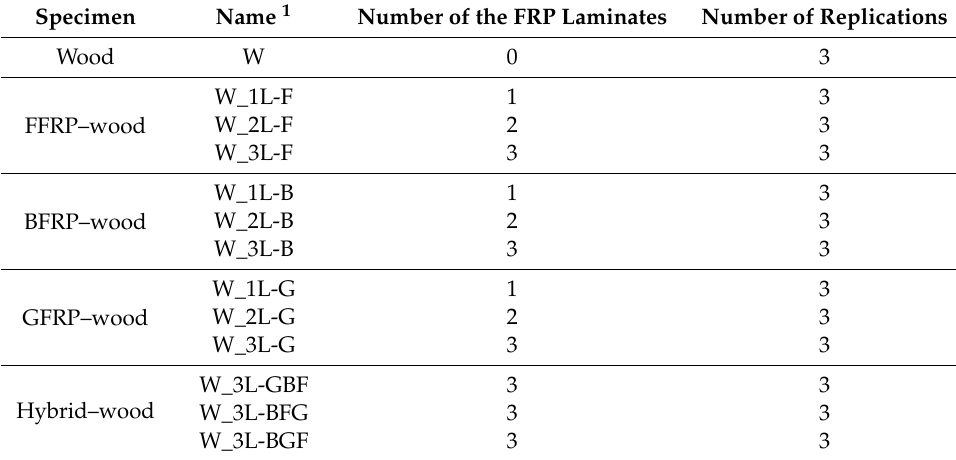
Table 1. Matrix of the specimens.